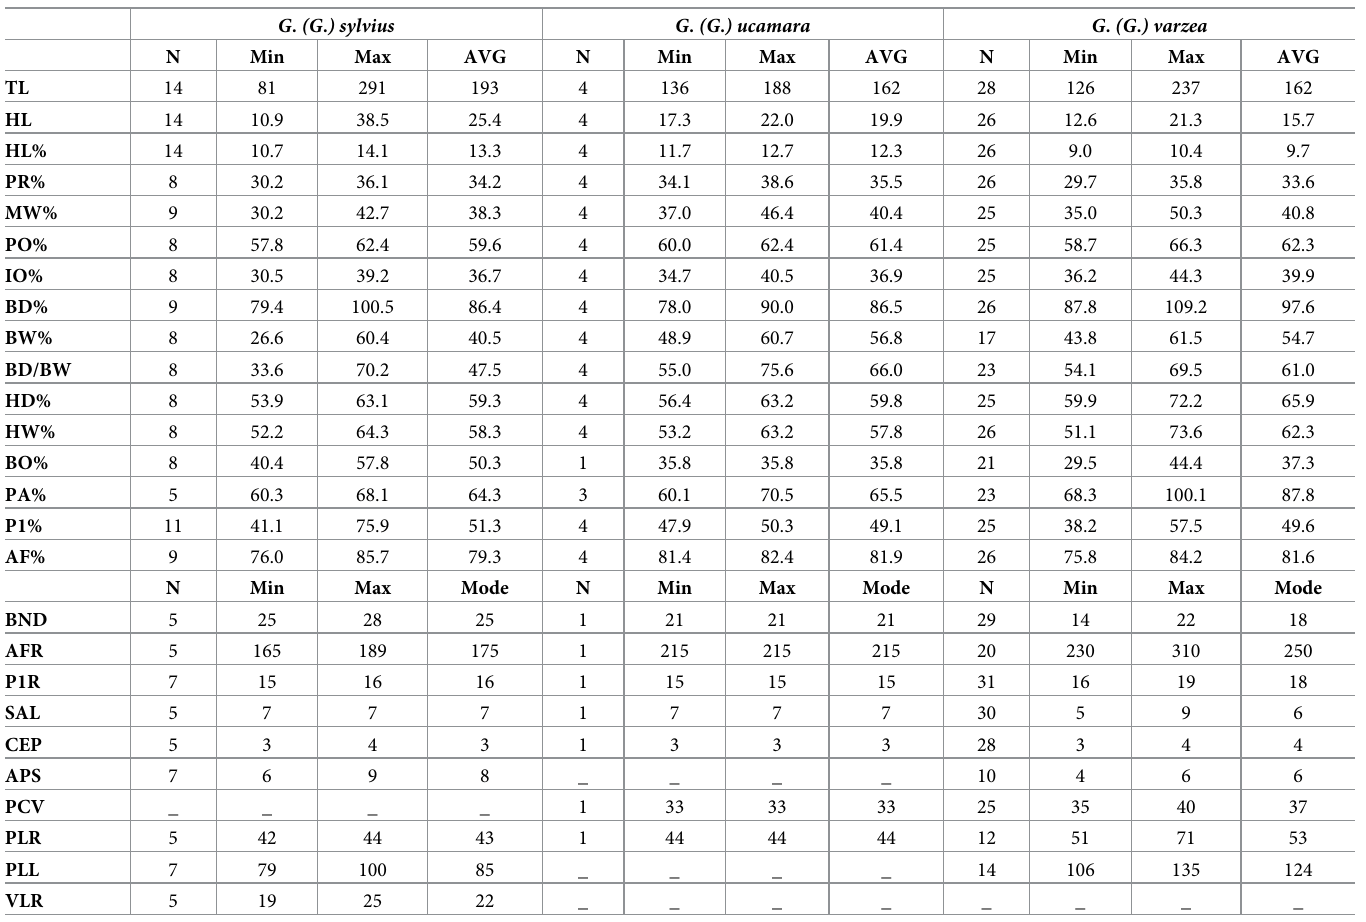
Table 12. Summary of morphometric and meristic data for Gymnotus (G . ) sylvius , G . (G . ) ucamara and G . (G . ) varzea . G . (G . )